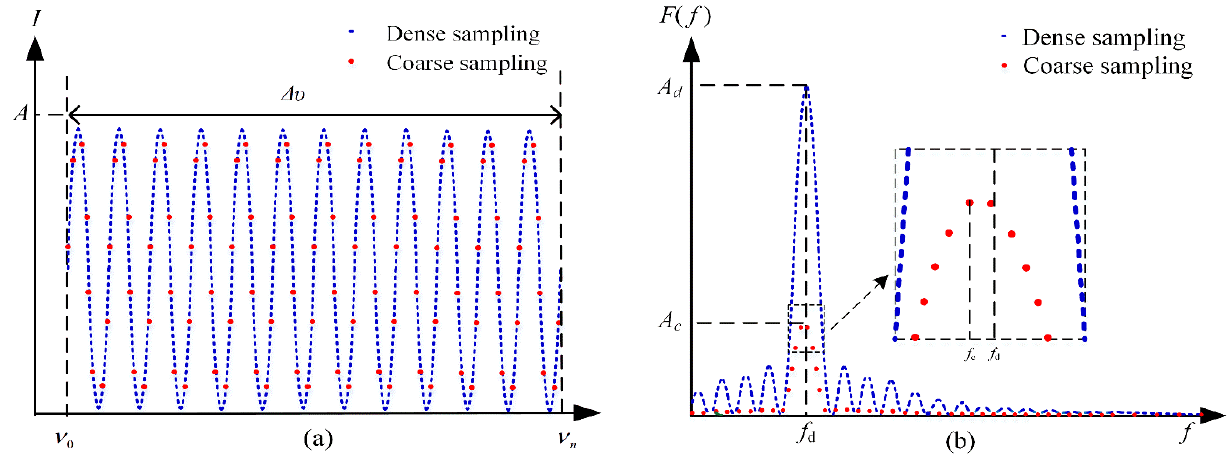
Figure 2. ( a ) The spectrum of dense sampling and coarse sampling and ( b ) the FFT results of the spectrum of dense sampling and coarse sampling.